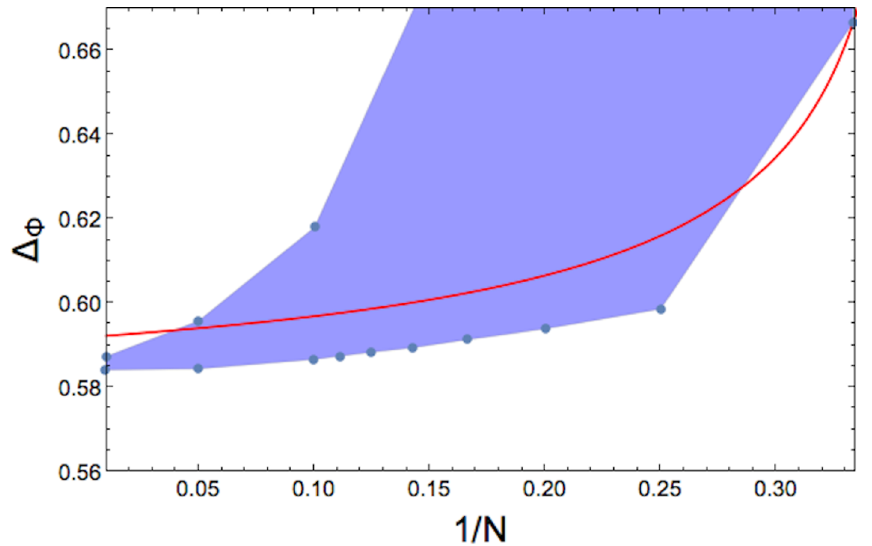
as a function of the flavor symmetry Φ using (cid:15) Φ